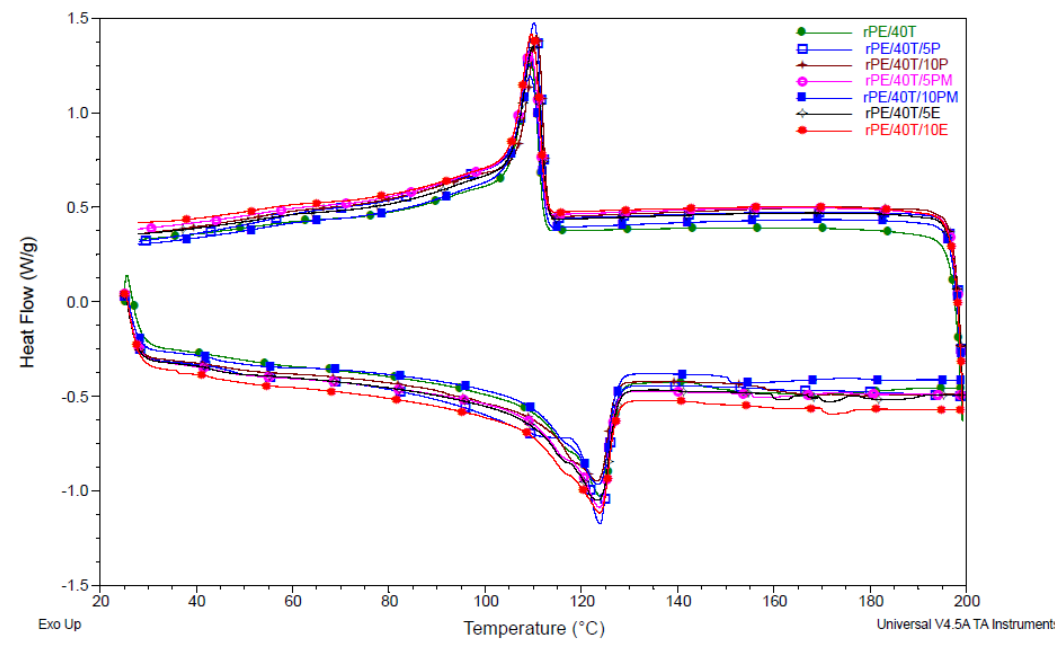
Figure 5: DSC curves of prepared r-LDPE/TPS based blends.